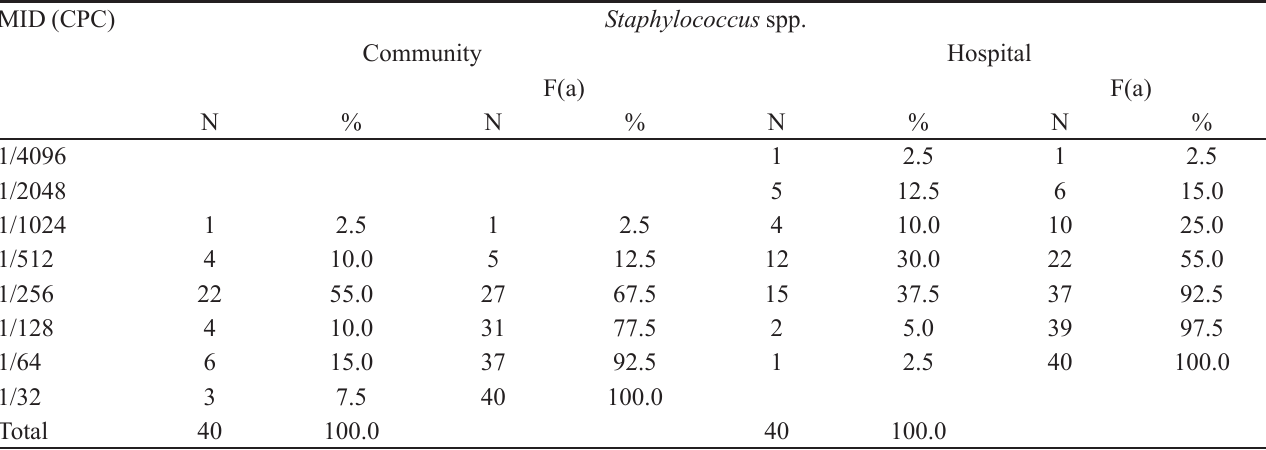
TABLE II - Numbers, Percentages and Accumulated frequency F(a) of the MID of Listerine ® as to Staphylococcus spp. isolated in the saliva of individuals from the community and hospital. Ribeirão Preto. 2006